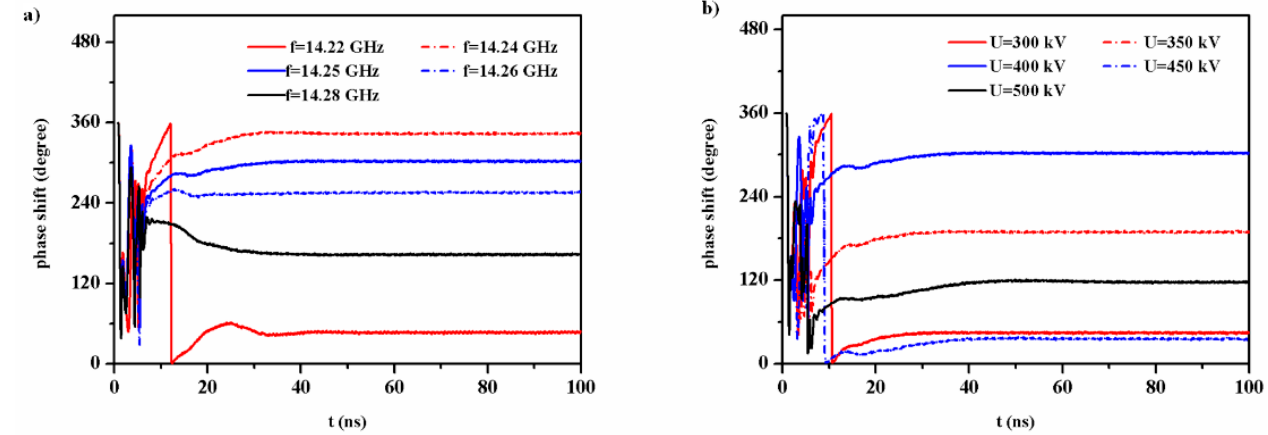
Figure 12. ( a ) Phase shift versus input frequency. ( b ) Phase shift versus diode voltages.